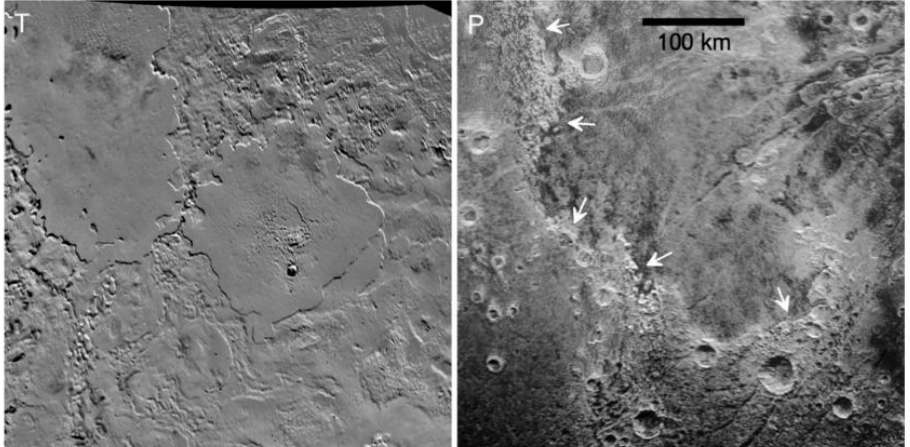
Figure 29. Walled plains on (T) Triton and (P) Pluto. Images shown to same scale (0.35 km/pixel) and same dimensions; scene width ~400